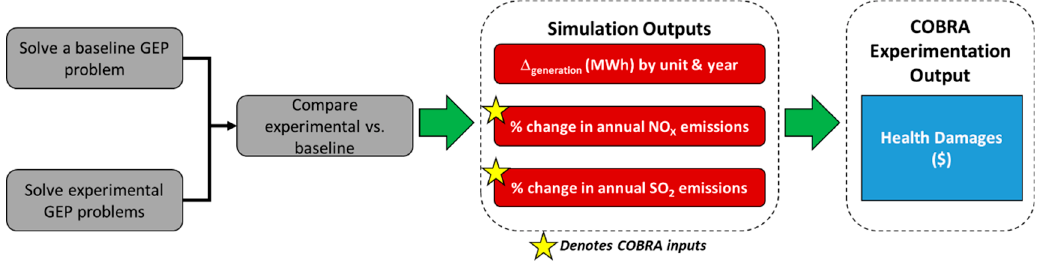
Figure 2. Simulation and Experimentation Procedure.